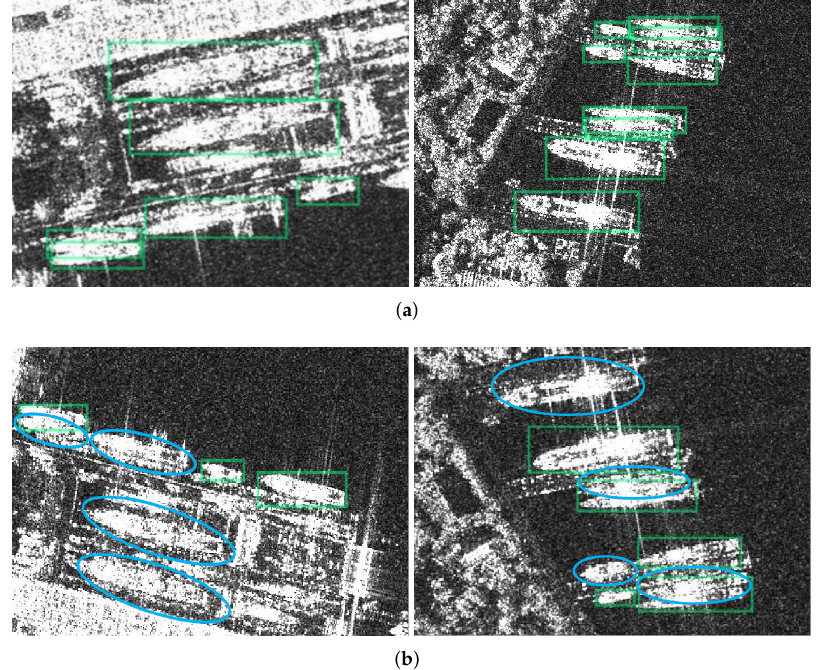
Figure 16. Comparison detection results of angle-transformed SAR images. The spring-green rectangles represent the detection results. The blue circles represent the missing ships. ( a ) Satisfactory results. ( b ) Undesirable results.